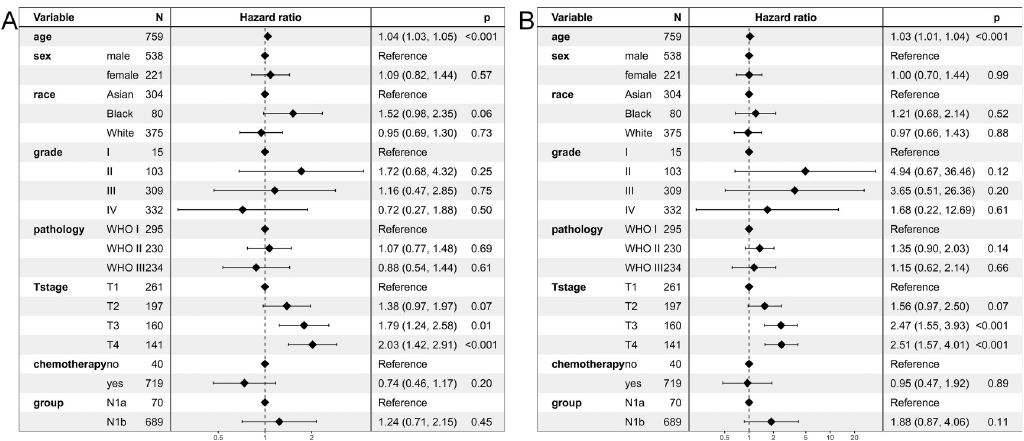
Fig 3. Multivariate regression analysis of prognostic factors for survivals in the unmatched cohort. (A) Overall survival. (B) Cancer-specific survival.